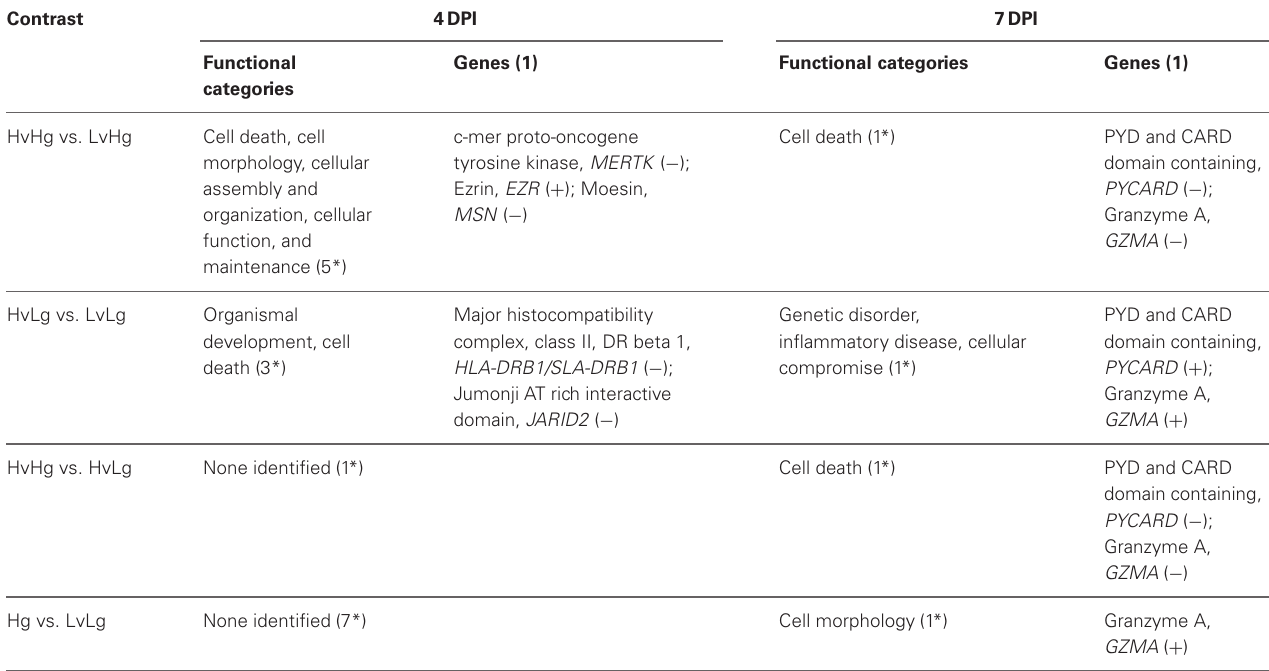
Table 2 | Functional categories enriched for DE genes at 4 and 7DPI.